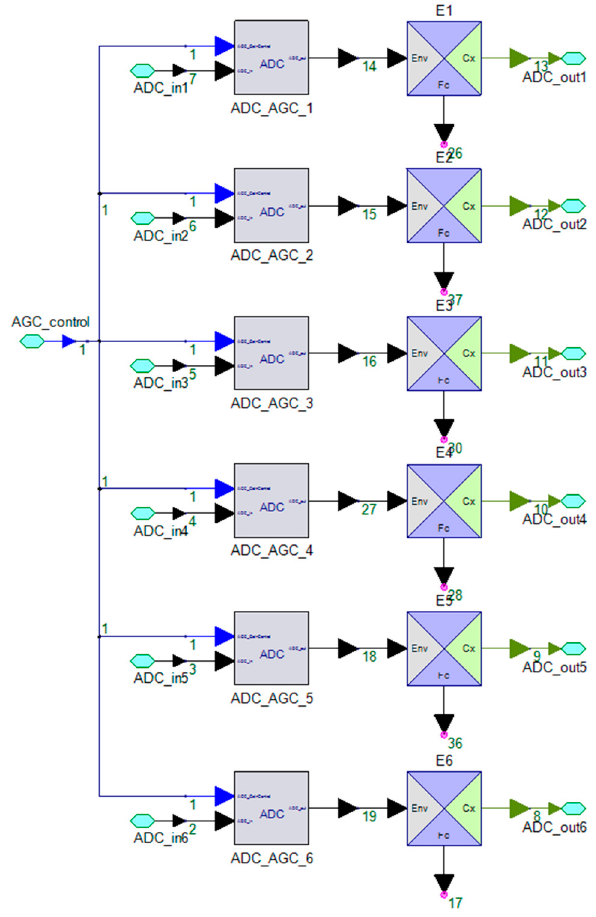
Figure A9. The model inside Six_ADC_with_AGC block.